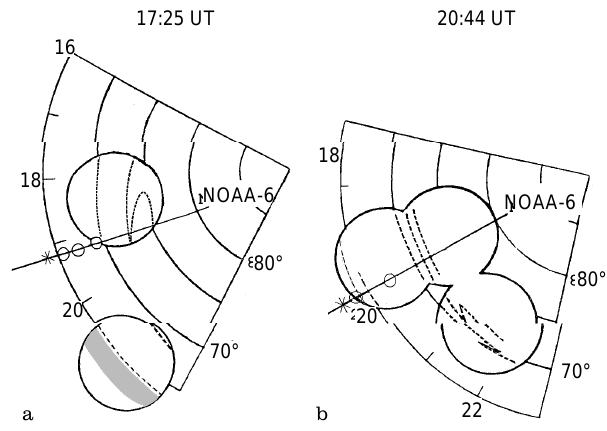
Fig. 3 . Maps (in polar coordinates MLT-inv. lat.) of the aurora seen in the field of view of the all-sky cameras during the NOAA-6 satellite passes of 24 November 1981. Left : for the event 10; right : for the